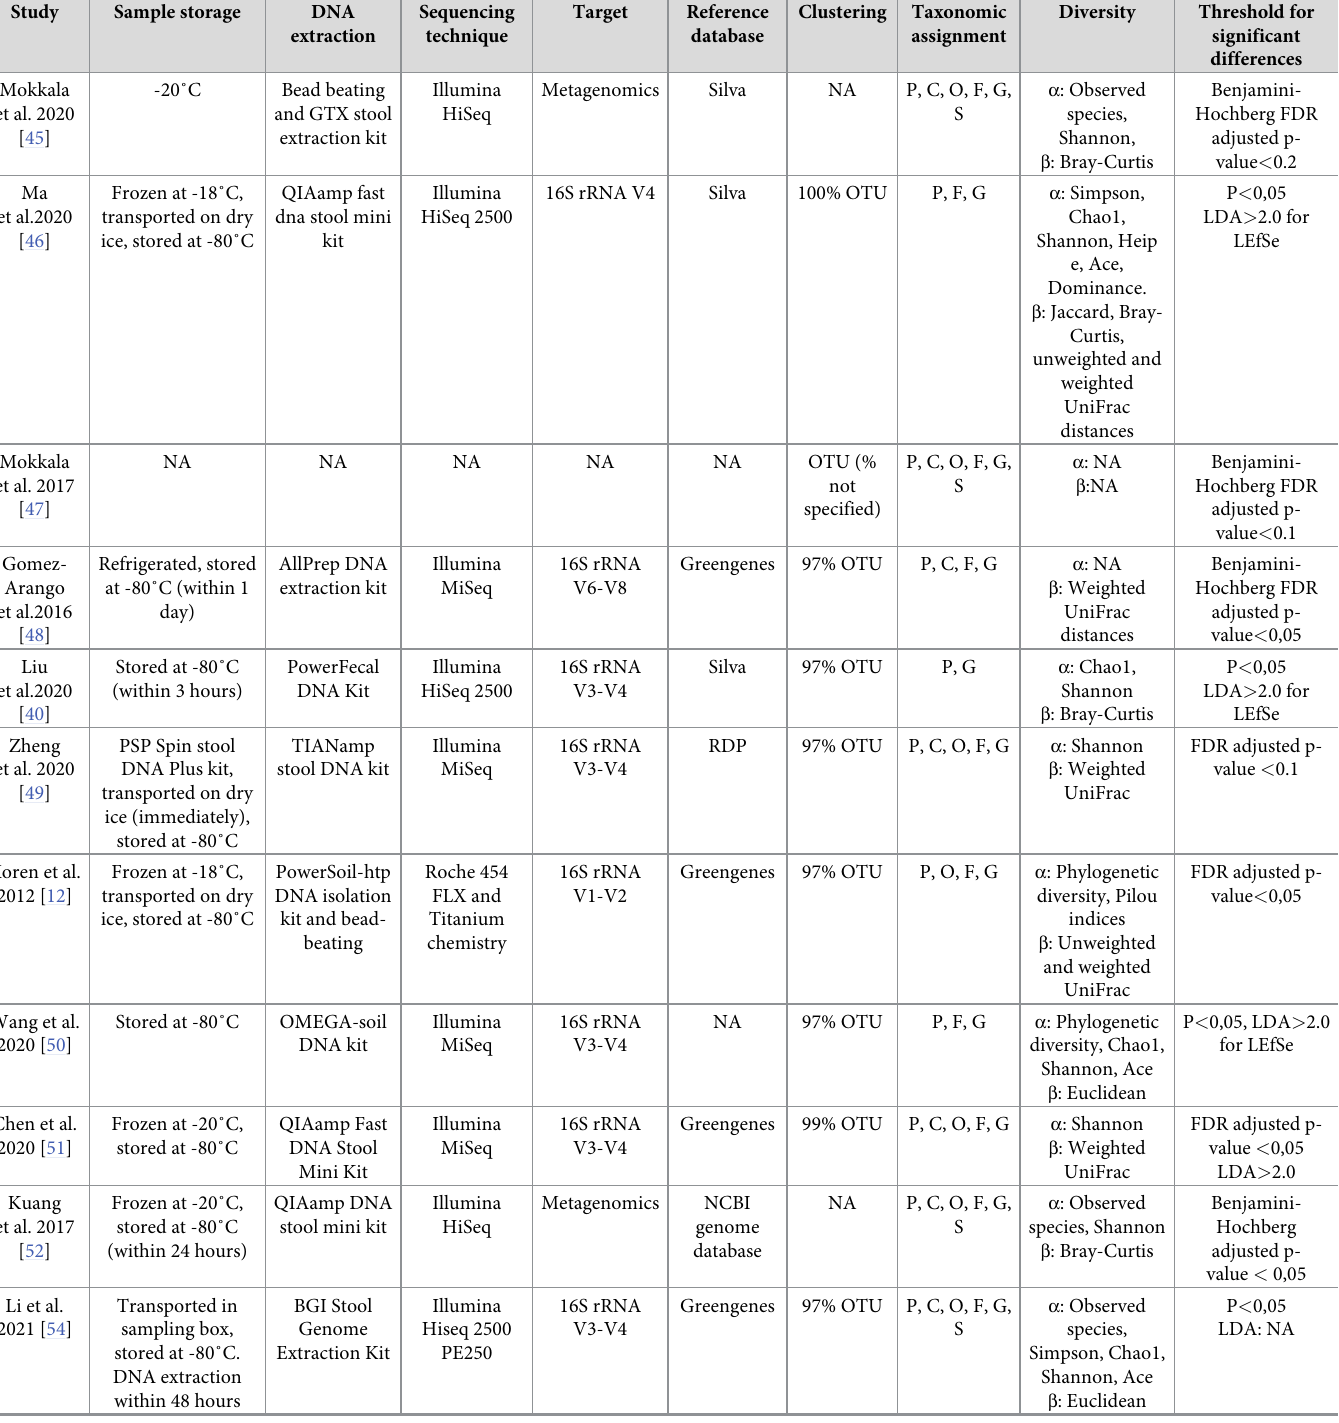
Table 2. Handling of samples from GDM and non-GDM participants in the included